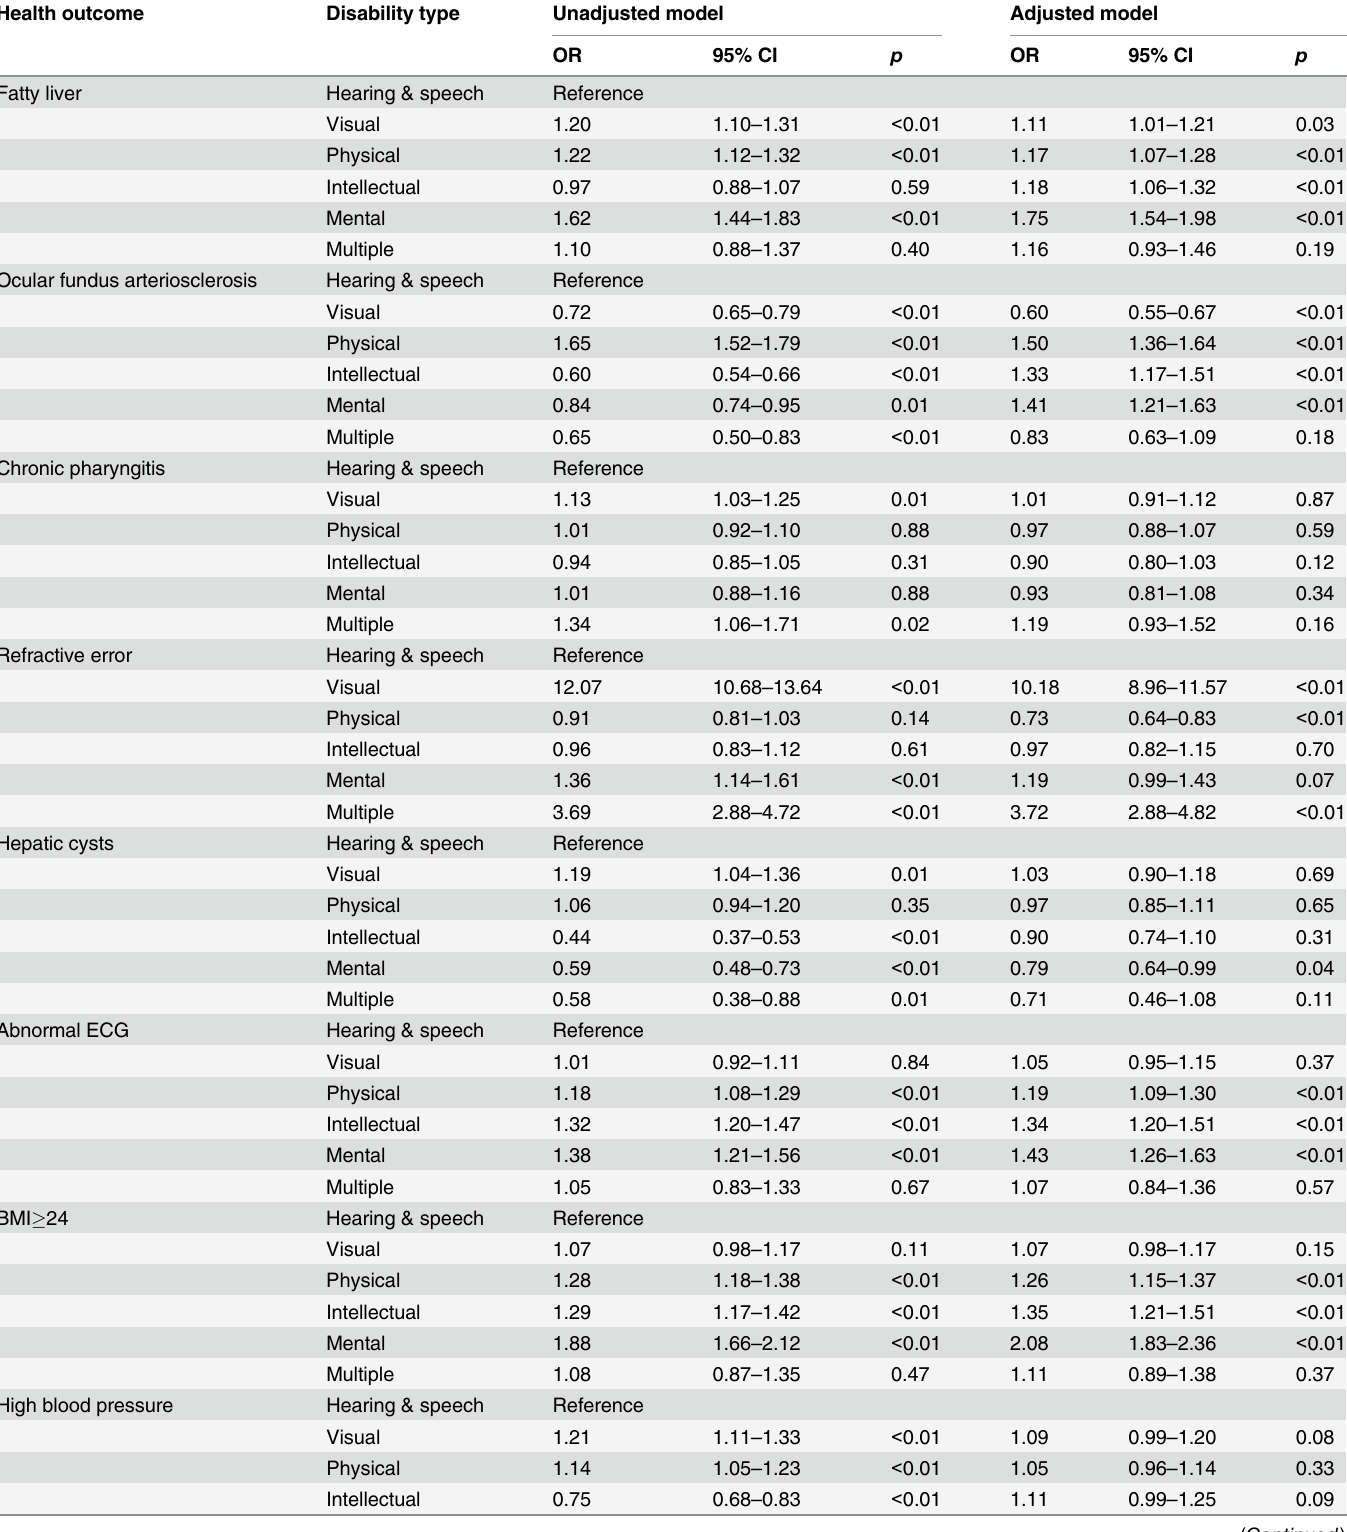
Table 4. Health disparities by different disability type in unadjusted and adjusted